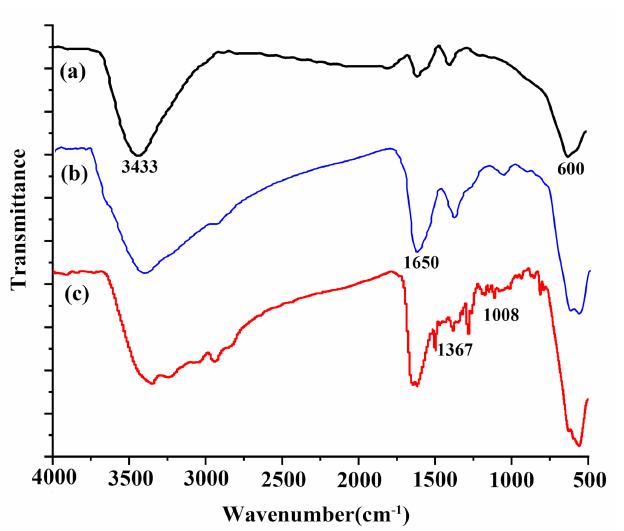
Figure 6. Infrared spectra of ( a ) Fe 3 O 4 , ( b ) Fe 3 O 4 @PDA and ( c ) Fe 3 O 4 @PDA@PEI